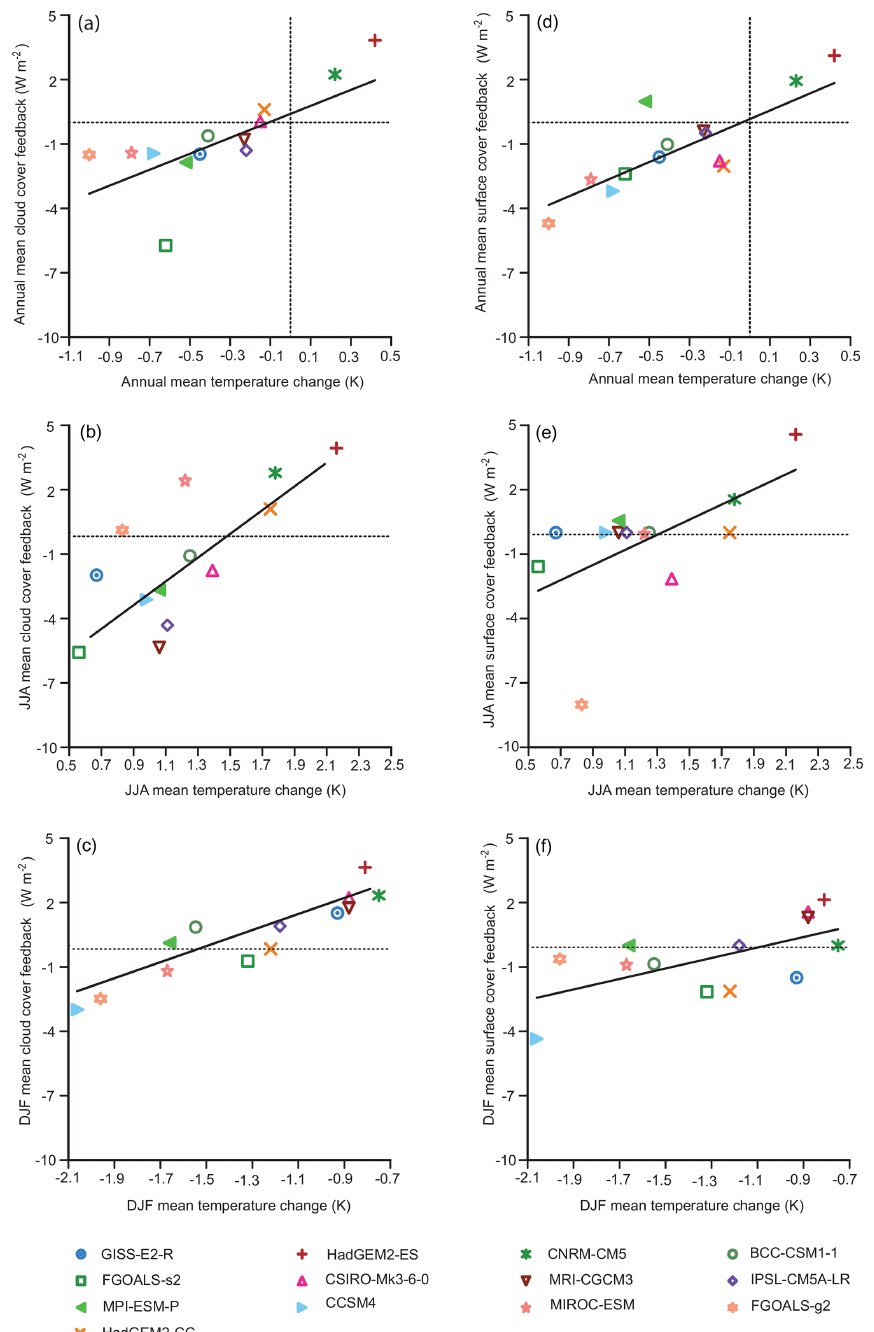
Figure 10. Scatter plots showing temperature, cloud cover feedback and surface albedo feedback changes during the MH. The values shown are the simulated 30-year mean anomaly (MH–PI) for the 13 models. (a) Annual mean temperature relative to the annual mean cloud cover feedback and (d) annual surface albedo feedback. (b) Summer (JJA) mean temperature relative to the summer mean cloud cover feedback and (e) summer surface albedo feedback. (c) Winter (DJF) mean temperature relative to the summer mean cloud cover feedback and (f) winter surface albedo feedback. The horizontal and vertical lines in the plots represent the value of